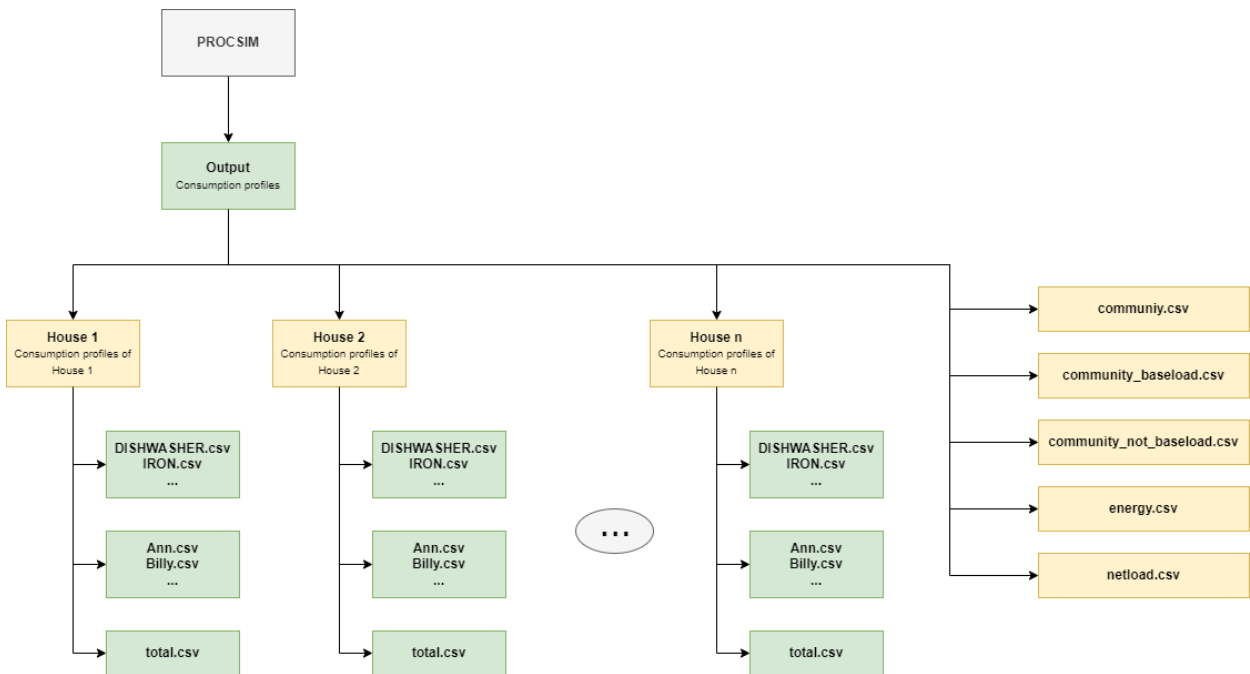
Figure 4. EC dataset structure.